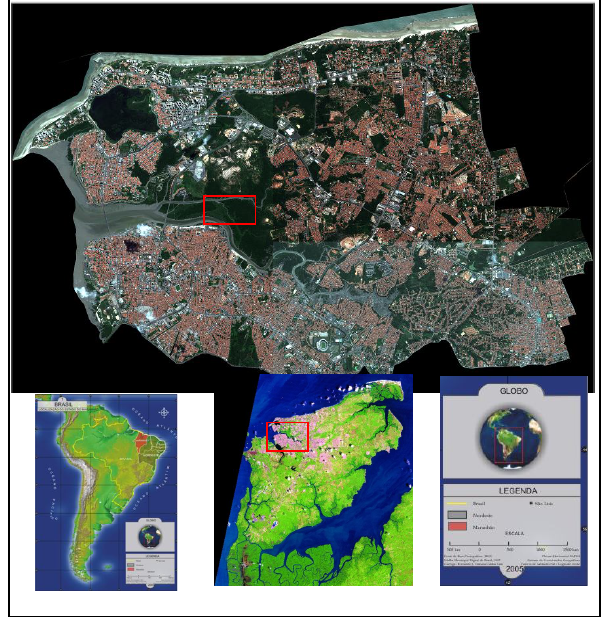
Figure 3 – Localization of test site Source: Adapted from WorldView-2 image dated July 10 th 2010.